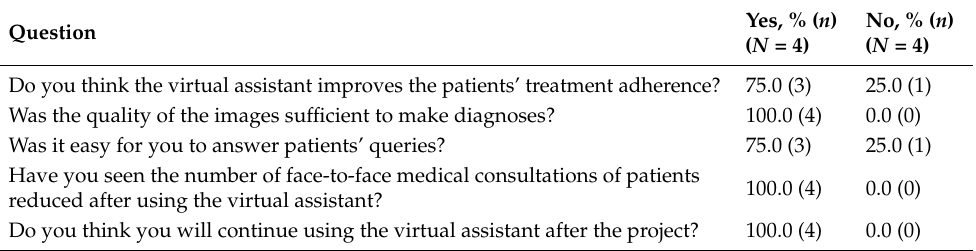
Table 8. Healthcare professionals’ responses regarding general use and perception of the virtual